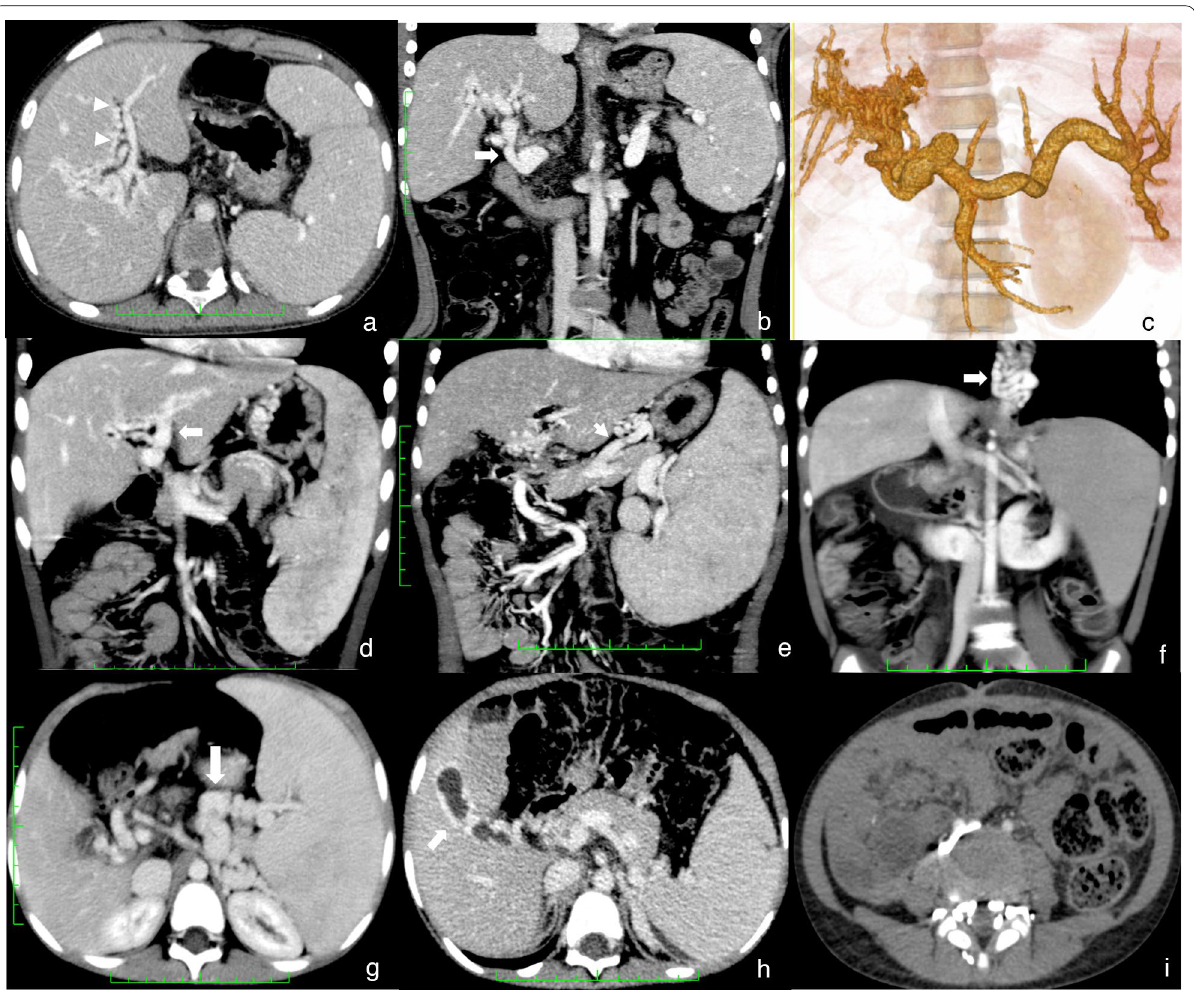
Fig. 3 Imaging manifestations of extrahepatic portal vein obstruction in children. a – c Cavernous transformation (white triangle) in the Rex recess. d Cavernous transformation of the portal vein (white arrow). e Gastric coronary varices. f Esophageal-gastric varices (white arrow). g Splenorenal shunt (white arrow). h Gallbladder varices. i Paravertebral